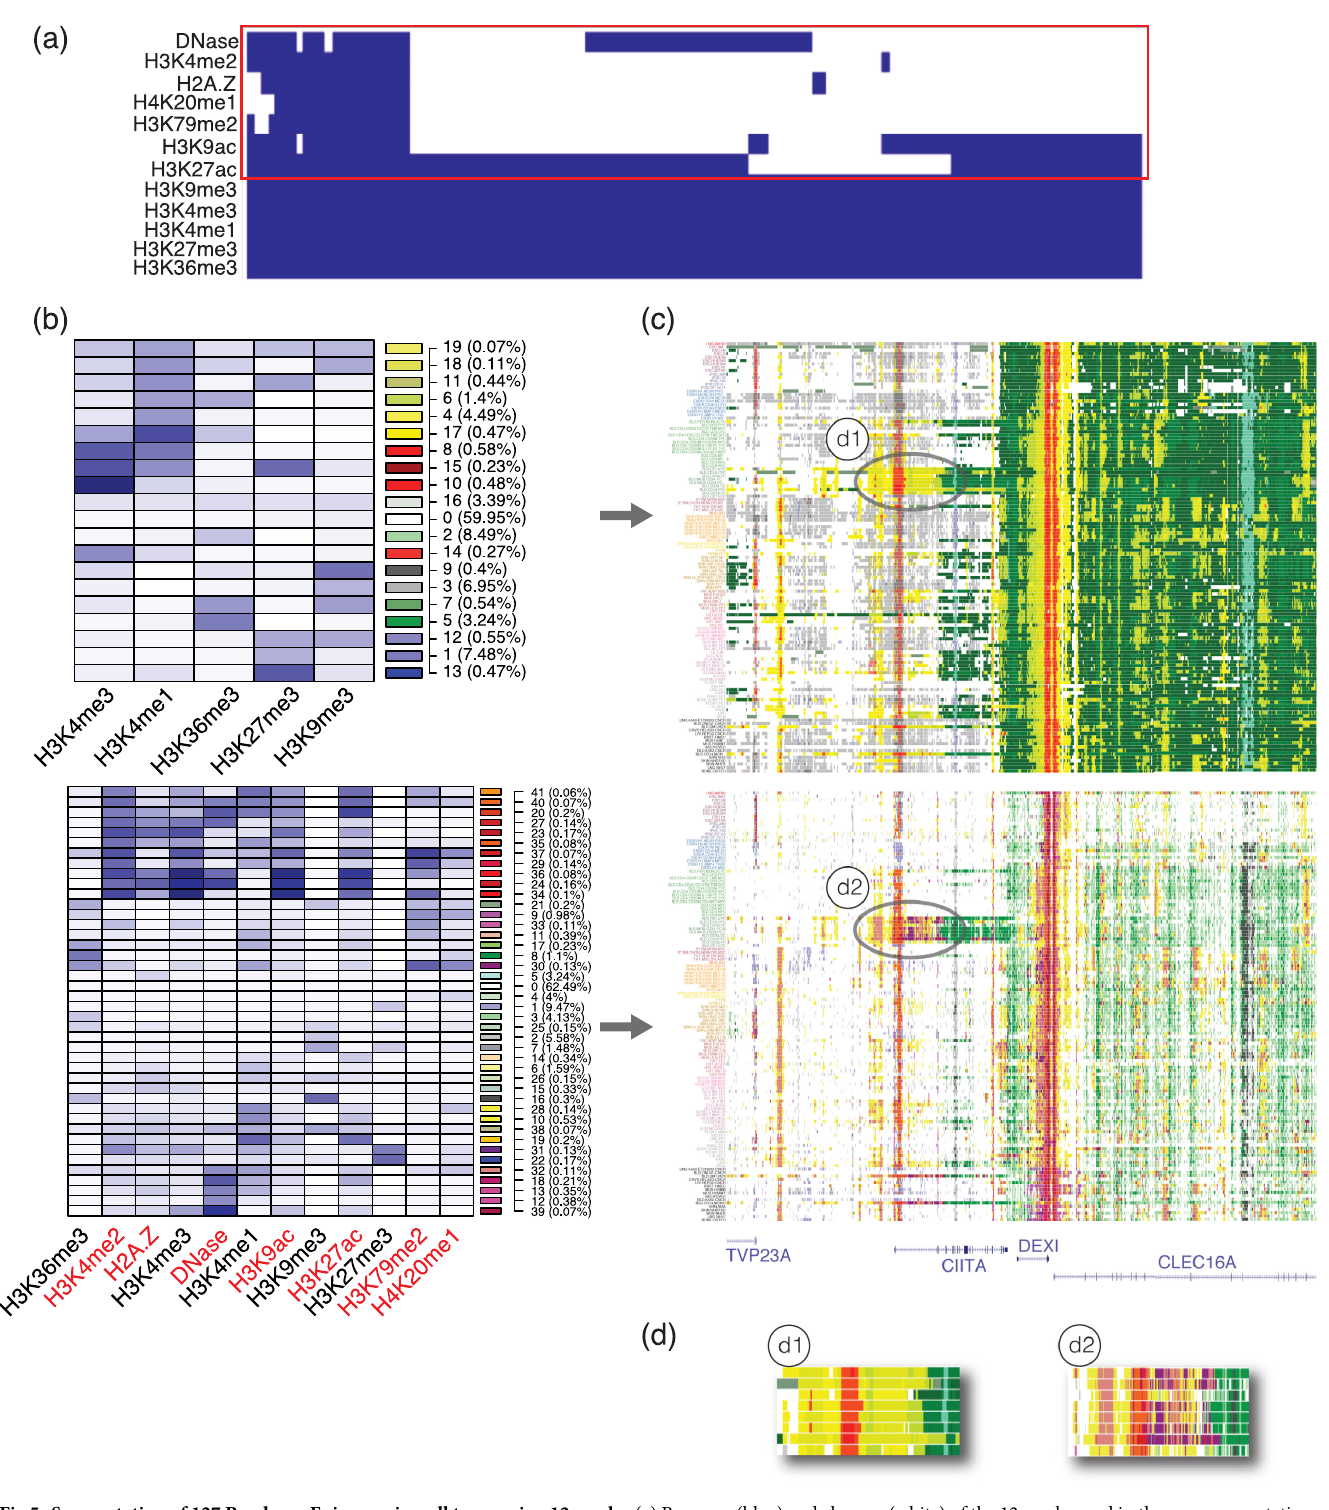
Fig 5. Segmentation of 127 Roadmap Epigenomics cell types using 12 marks. (a) Presence (blue) and absence (white) of the 12 marks used in the new segmentation. Red box indicates the 7 new marks. (b) Mean signals of chromatin states in the previously published 5-mark map (top) compared with the mean signals of chromatin states inferred using 12 marks (bottom). State colors used in genome browser are shown on the side in each row, along with state ID and proportion of the state in the genome. (c) Example browser view of the previous map compared to the new map at the CIITA gene (hg19 chr16:10,900,000–11,150,000). (d) Zoomed in views at CIITA